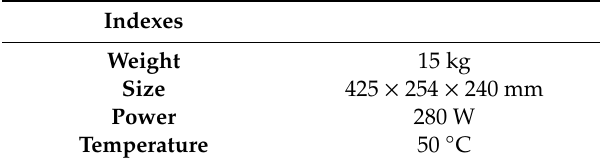
Figure 2. Illustration of system simulating the on-board environment and processing routine for method validation. method validation. Table 1. Hardware scale of the specific on-board processor